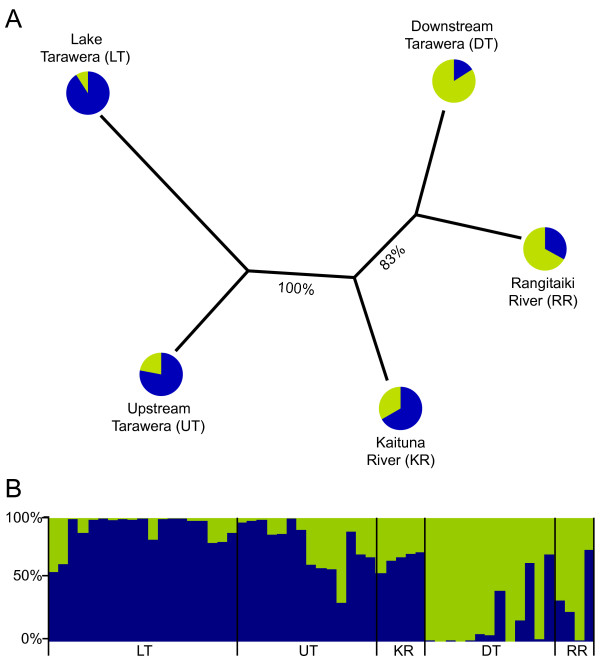
Analyses of genetic structure among sample locations as inferred from AFLP fingerprints. A: Population dendrogram. Numbers on branches are percent bootstrap values out of 1,000,000 pseudo-replicates: Pie diagrams at branch ends illustrate mean proportions of inferred genotypes in the respective sample sites. B: Detailed STRUCTURE bar plot illustrating genotypic composition. Colours are inferred green (light shading) and blue (dark shading) genotypes. X-axis: each vertical bar represents one individual. Y-axis: proportion of genotypes. Labels refer to sample sites as given in A.